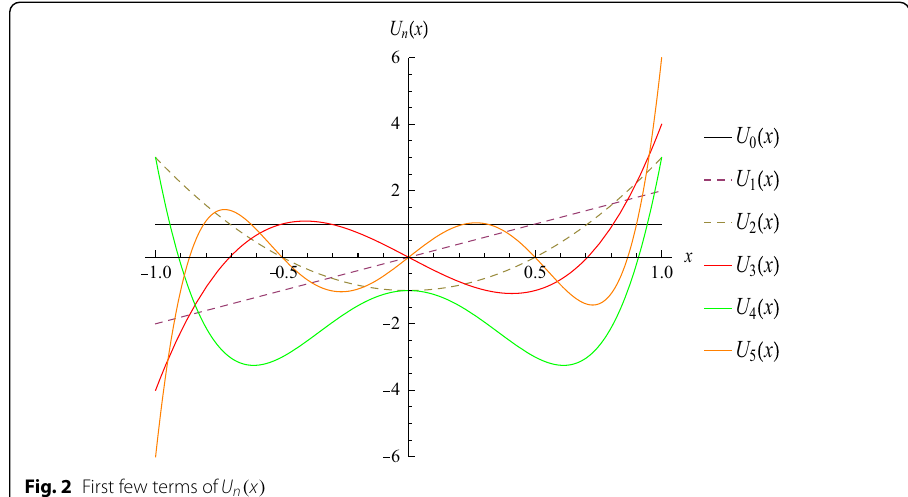
Fig. 2 First few terms of U n ( x